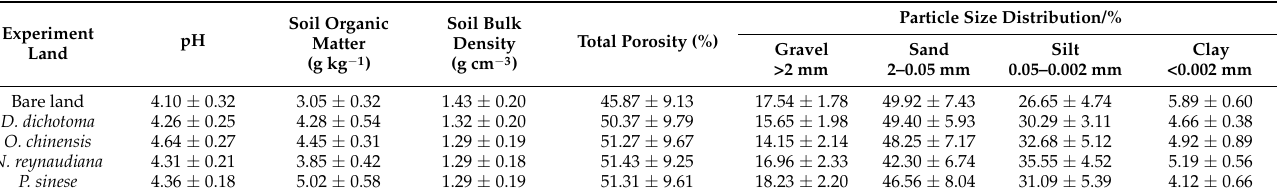
Table 2. Soil properties in different vegetation